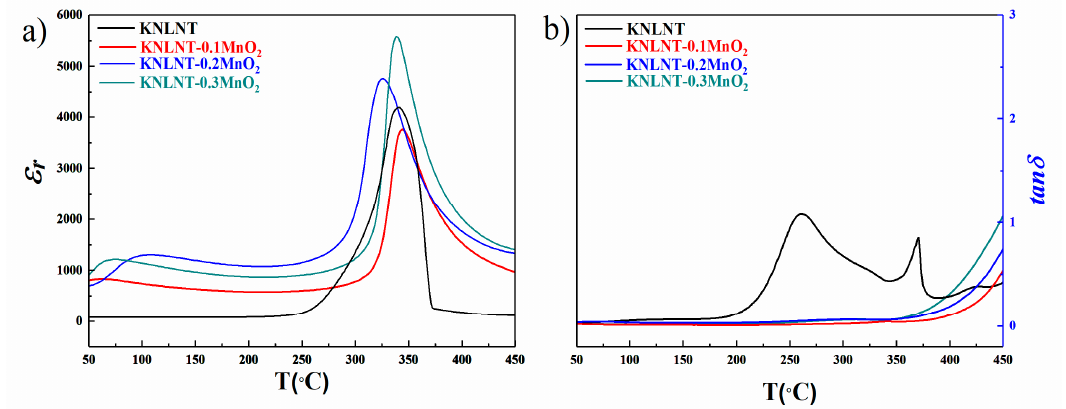
Figure 4. Temperature dependence of ( a ) dielectric constant ε r , and ( b ) dielectric loss tan δ , measured at a frequency of 1 kHz for poled KNLNT- x Mn ( x = 0.0, 0.1, 0.2, 0.3) ceramics.